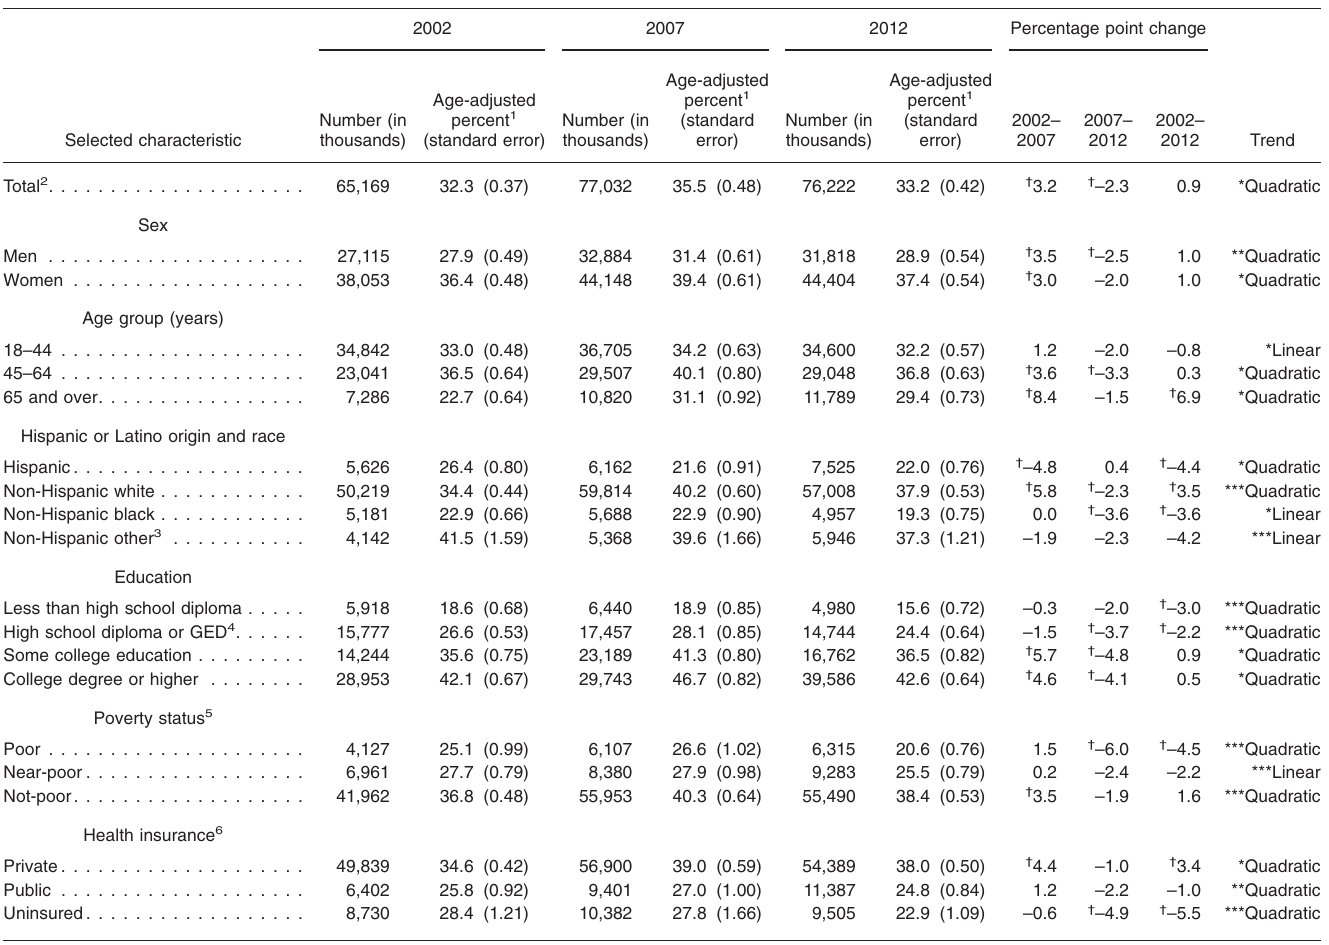
Table 2. Trends in the use of complementary health approaches among adults aged 18 and over, by selected characteristics: United States, 2002, 2007, and